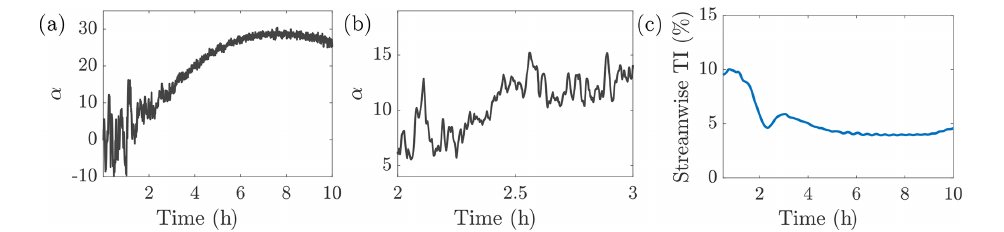
Figure 2. Diurnal cycle flow (a) hub-height wind direction, (b) hub-height wind direction zoomed in to show variations between hours 2 and 3, and (c) hub-height turbulence intensity.